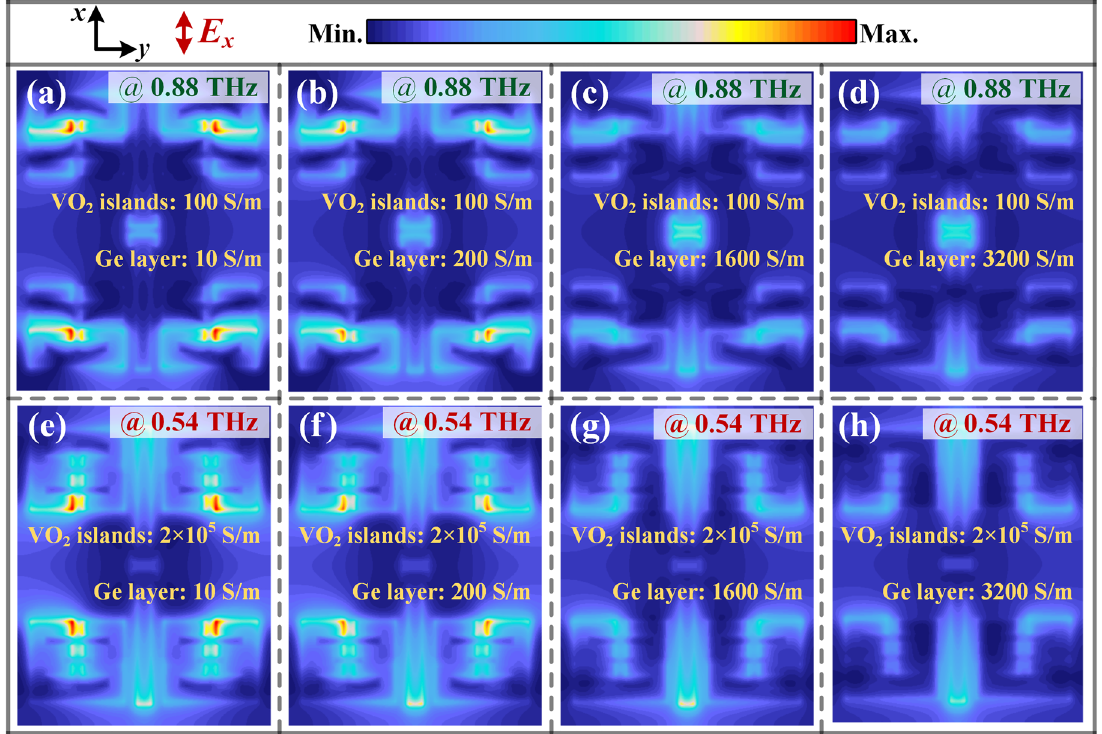
Figure6: Near-fieldsimulationsfortheproposedmultifunctionalmetasurfacesbyvaryingtheconductivityoftheGelayerfor(a) – (d)insulator and (e) – (f) metallic VO 2 bridges,